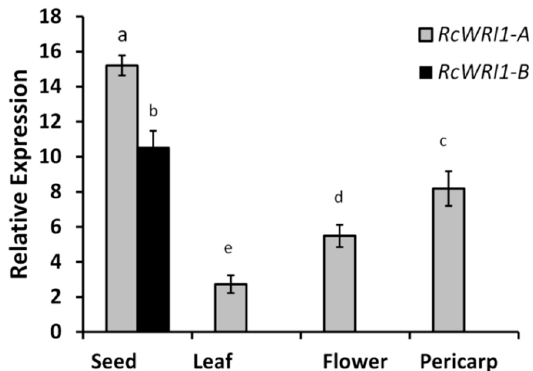
Figure 3. Expression of RcWRI1-A and RcWRI1-B in major castor bean organs. Expression profiles were determined by qRT-PCR using total RNA from leaves, flowers, pericarps, and developing seeds. RcActin was used as an internal control. Each value is the mean ± SD of six biological replicates. Letters a, b, c, d, e indicate significant differences at the level of p < 0.05 according to the Tukey’s test.